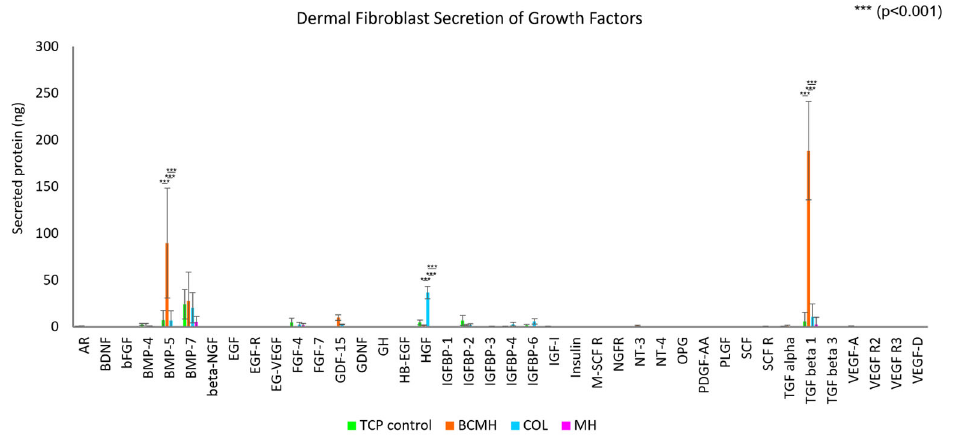
Figure 2. Amounts of growth factors secreted by primary dermal fibroblasts (5 × 105 cells per well) cultured 24 h with the test materials. n = 9 for each material.